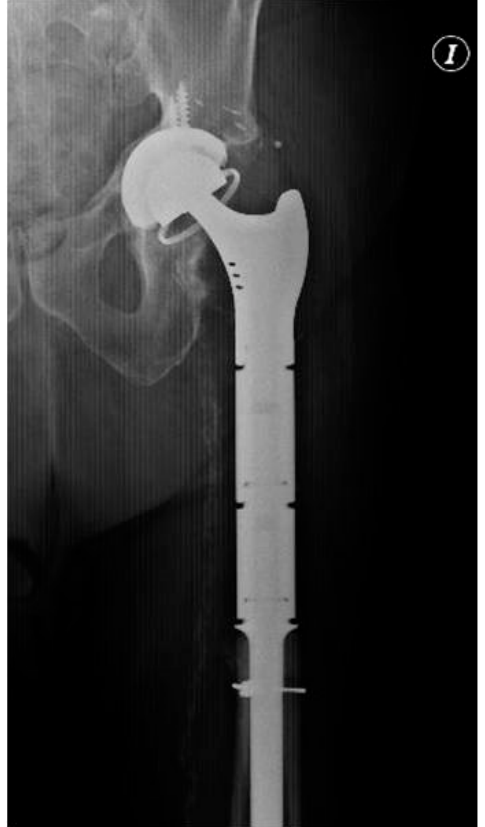
Figure 2. Hip radiography showing the implanted prosthesis.